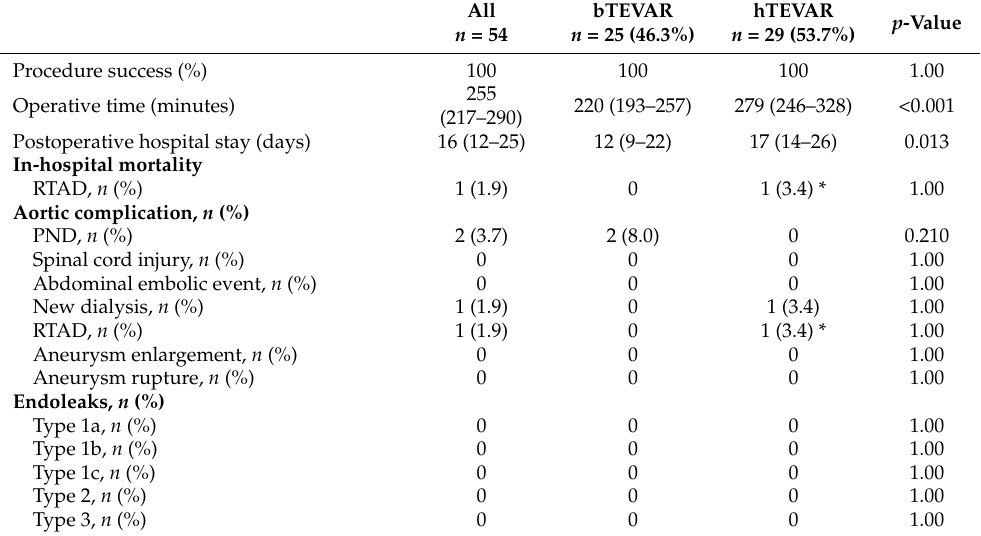
Table 3. Operative and in-hospital